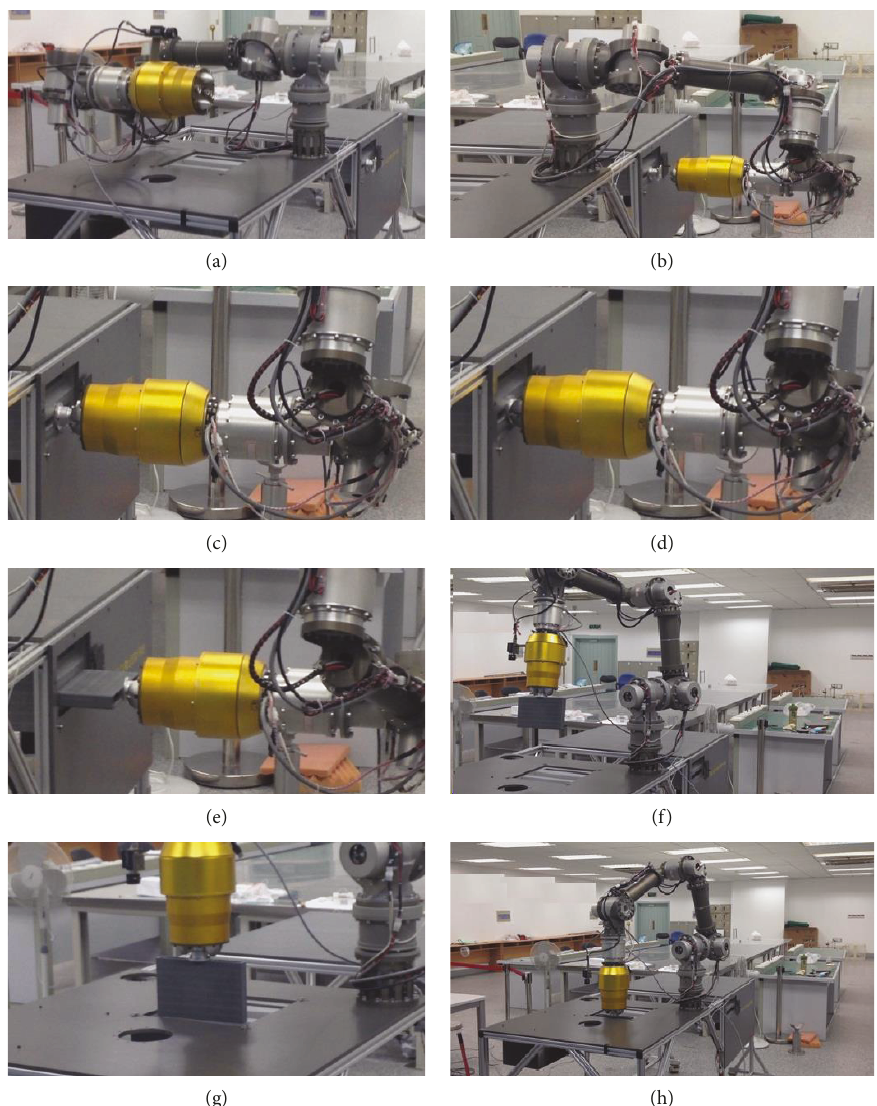
Figure 19: ORU changeout experiments: (a) initial state, (b) free motion, (c) adapter approaching, (d) ORU capturing and locking, (e) ORU extracting, (f) free motion, (g) ORU inserting, and (h) ORU inserting fi